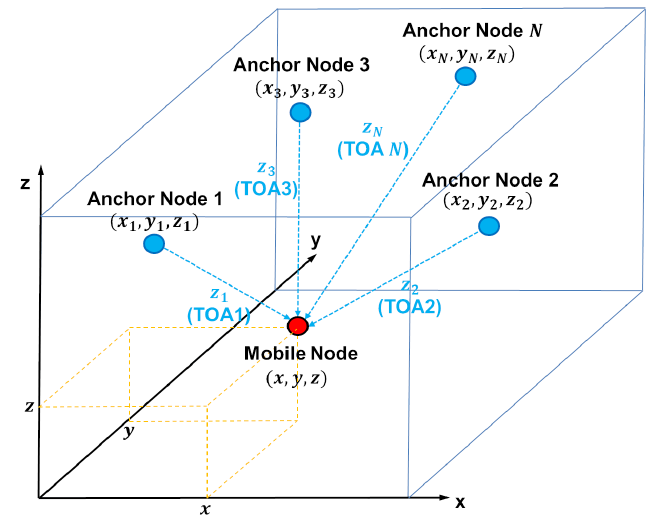
Figure 1. Geometry of 3D localization using